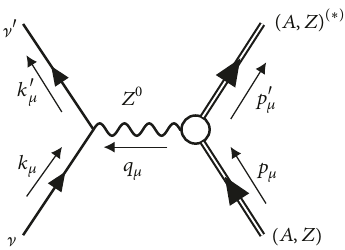
Figure 1: A diagram of the neutral-current scattering process. The four momenta of the involved particles are labeled in the